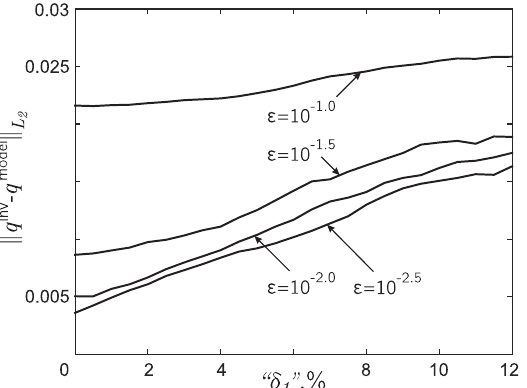
Figure 4. Exact model solution (function q model ( t ) ) and the result of its reconstruction (function q inv ( t ) ) from the input data of the inverse problem defined by function f 1 model parameters (10) and ε = 10 − 2 with error ( a ) δ 1 = 0 (matches δ = 0%) and ( b ) δ 1 ∼ 3.5 × 10 − 2 (matches δ = 5%).